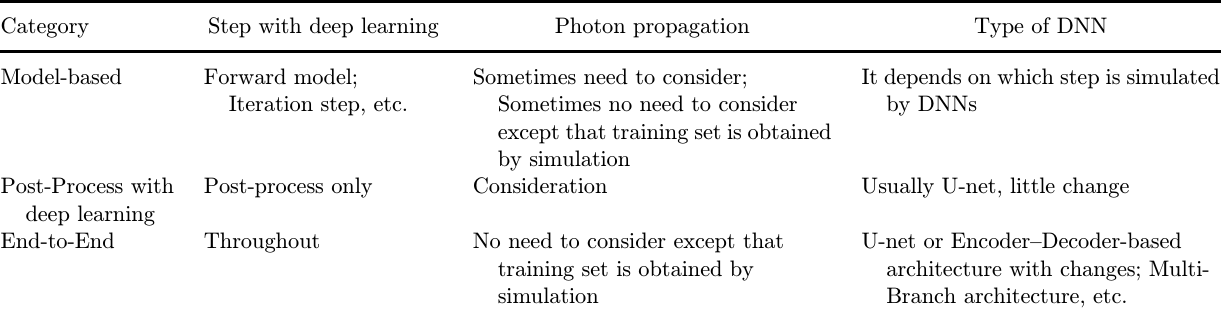
Table 2. Comparison for three categories of deep learning-based